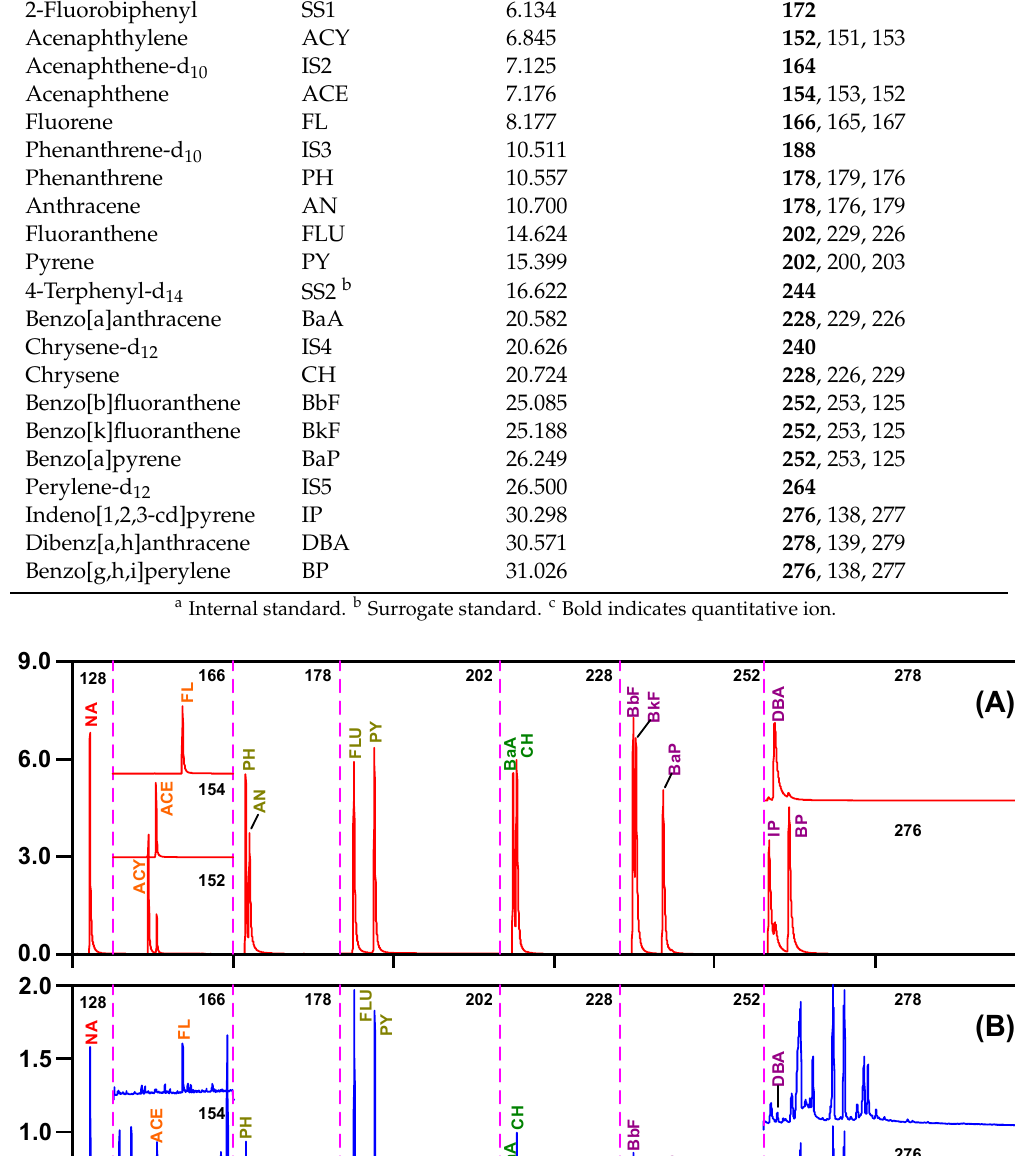
Table 2. Selected ion monitoring of each PAHs in GC-MS system.